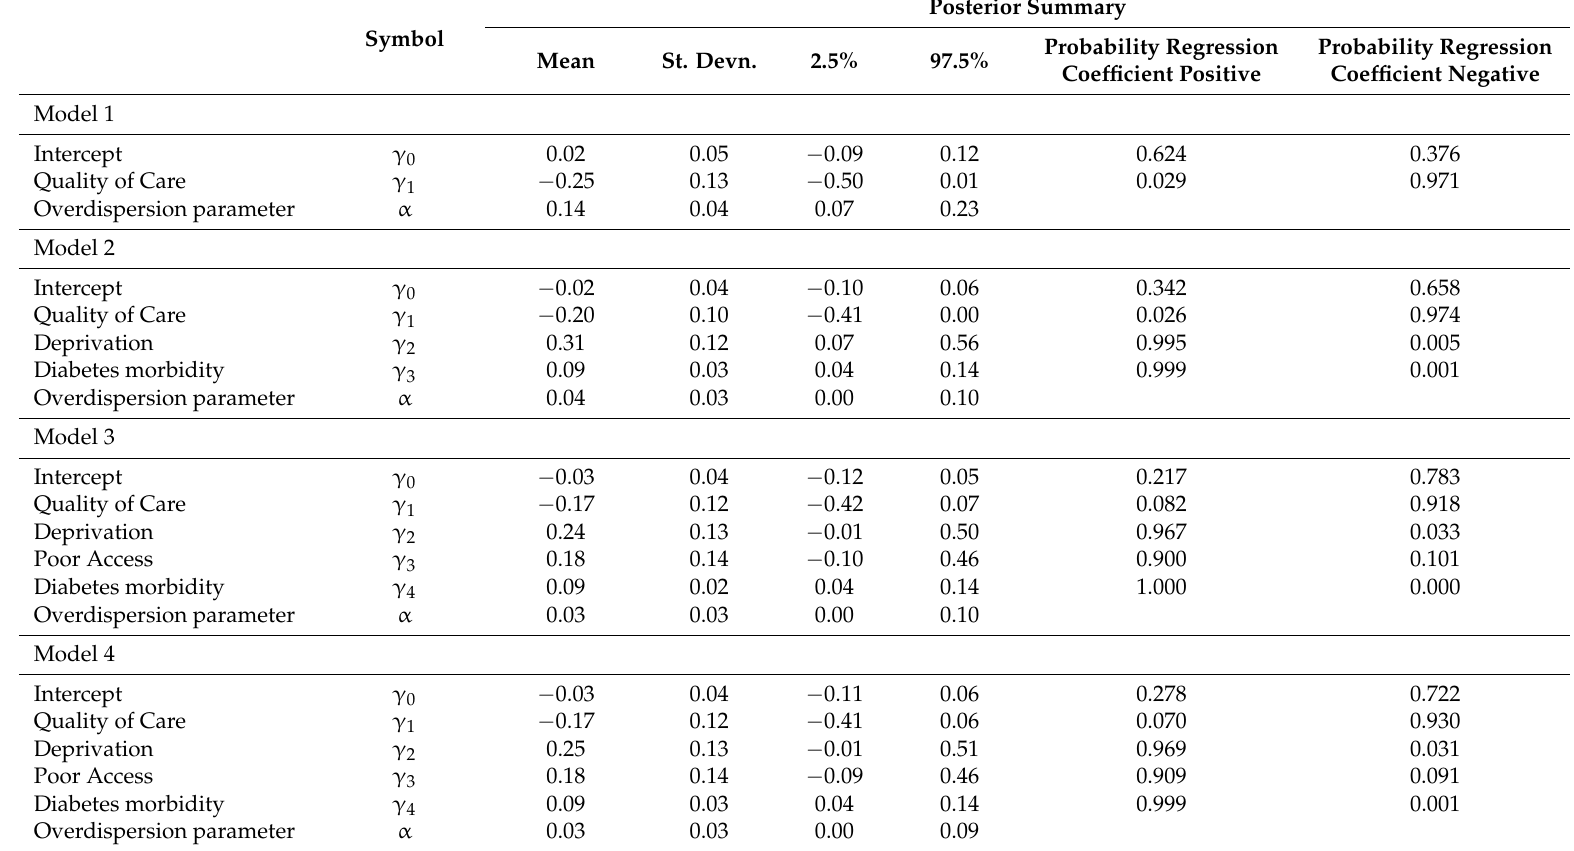
Table 3. Coefficients for outcome model (emergency diabetes related